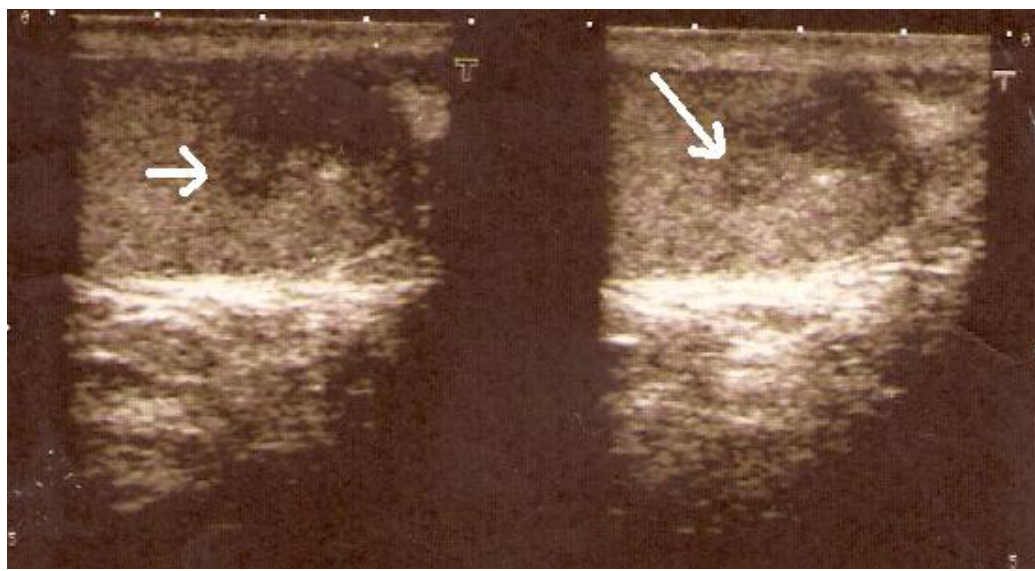
FIGURE 1. Doppler ultrasound image of the right testis. A nonvascularized, heterogeneous, hypoechoic, intratesticular mass is